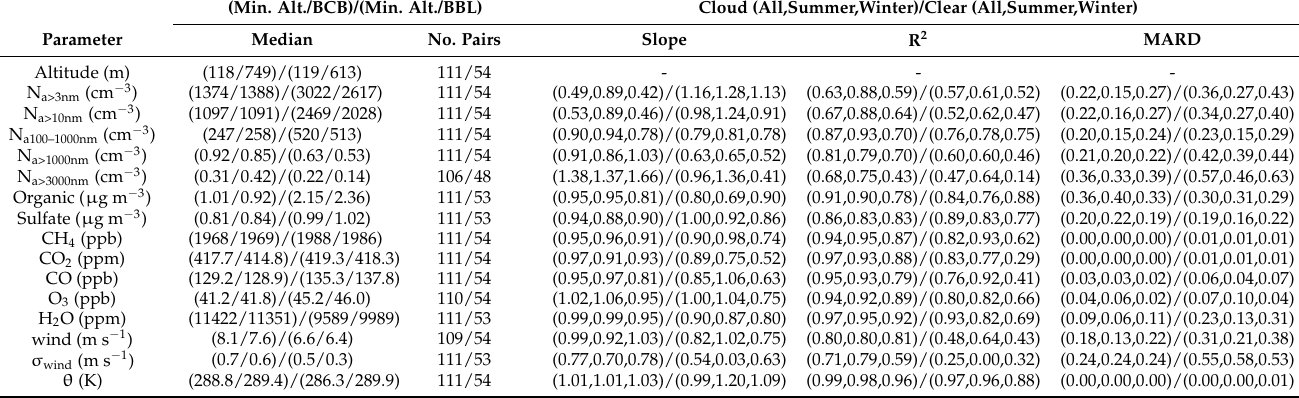
Table 3. Statistics for selected aerosol, gaseous, and meteorological variables measured during ACTIVATE 2020 flights. Statistics are calculated for Min. Alt./BCB legs and Min. Alt./BBL legs for cloud and clear ensembles, respectively, in the first two data columns (additional statistics for 25th/75th percentiles and minimum/maximum values are in Table S2). The rightmost three columns report correlation statistics between different leg pairs conducted at different heights within the MBL for cloud (i.e., Min. Alt. and BCB) and clear (i.e., Min. Alt. and BBL) ensembles, including separation for winter and summer